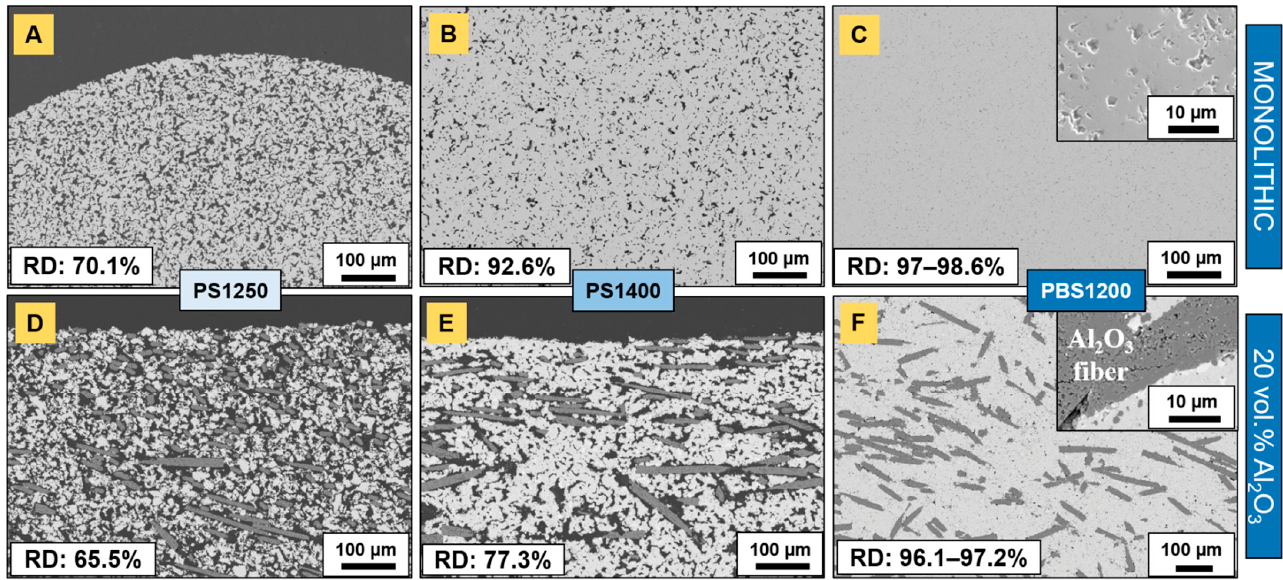
Figure 5. Backscattered electrons (BSE) images showing the microstructure of sintered Ti 2 AlC: ( A ) PS1250, ( B ) PS1400 and ( C ) PBS1200 of monolithic samples and ( D ) PS1250, ( E ) PS1400 and ( F ) PBS1200 of N720 aluminosilicate fiber-reinforced (20 vol.%) composites. RD designates the relative density. The insert in (C) is a secondary electrons (SE) image.